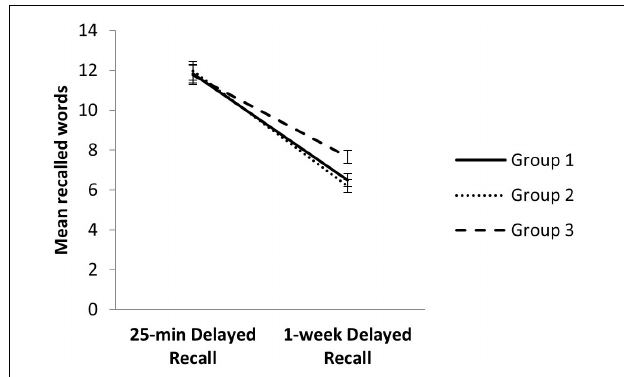
FIGURE 1 | Performance on 25-min Delayed Recall and 1-week Delayed Recall between modality groups. Error bars represent